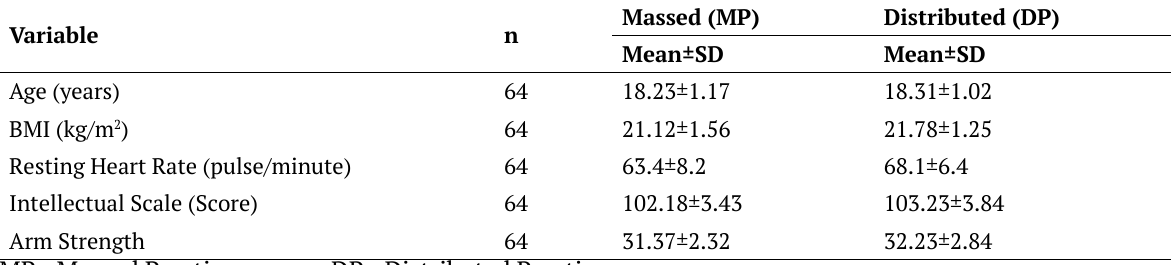
Table 1. Characteristics of Age, BMI, Resting Heart Rate, IQ, and Strength